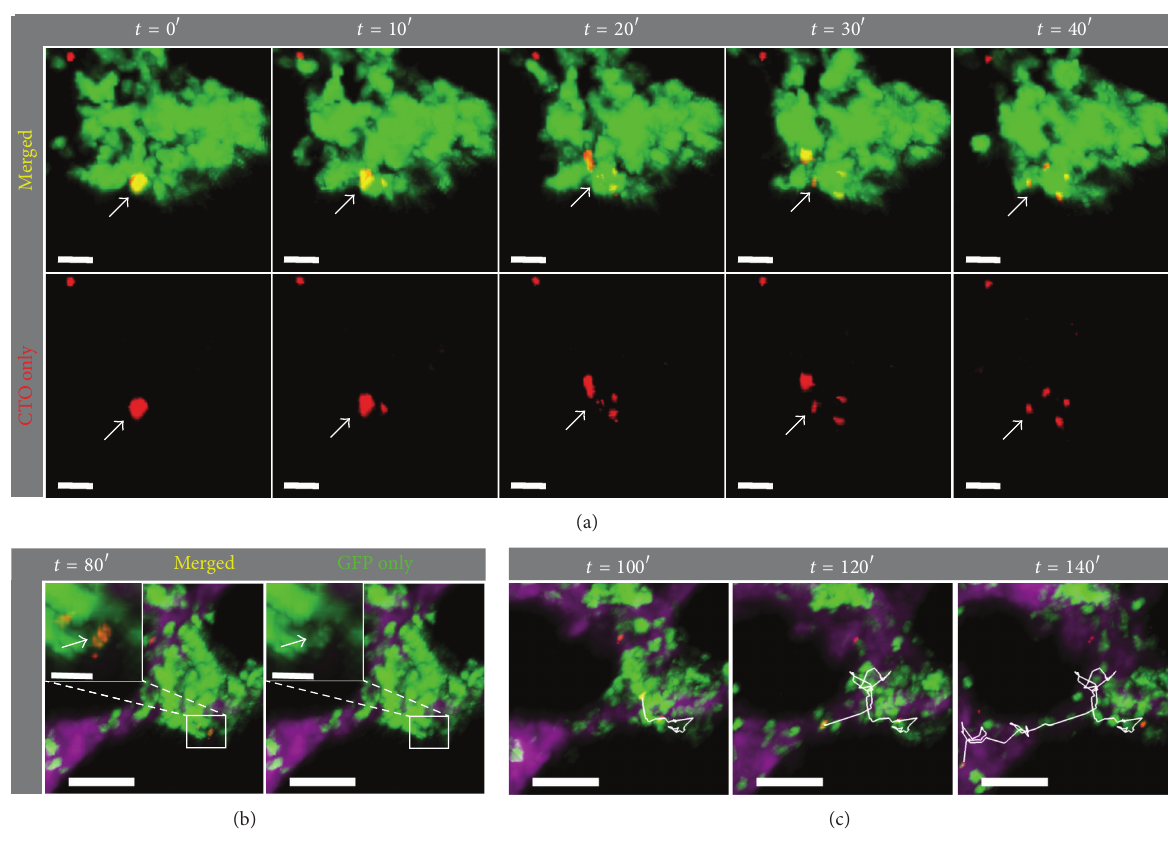
Figure 4: Cellular fragmentation of a dying hMSC followed by phagocytosis of migrating LysM + GFP + granulocyte engulfing hMSC debris. (a)IntravitalTPMimagesofadifferentareaofthecalvariumbonemarrowfromFigures 2 and3,demonstratingthedramaticfragmentationof the CTO-labeled (red) hMSC cell body (white arrow) into at least 4 pieces over a period of 40 minutes ( 𝑡 = 0 󸀠 corresponds to 20 minutes prior to LPS injection). Scale bar = 20 𝜇 m. (b) A LysM + GFP dim cell containing phagocytosed CTO-labeled hMSC debris is shown to demonstrate colocalization of GFP (green) and CTO (red) signals (inset: zoomed view at 𝑡 = 80 󸀠 with (left; “merged”) and without (right; “GFP only”) CTO signal). (c) A LysM + GFP + CTO + cell exhibited a highly motile behavior over a long distance in the bone marrow (white tracks) over a 60-minute imaging period. Scale bar outset = 50 𝜇 m; inset scale bar = 10 𝜇